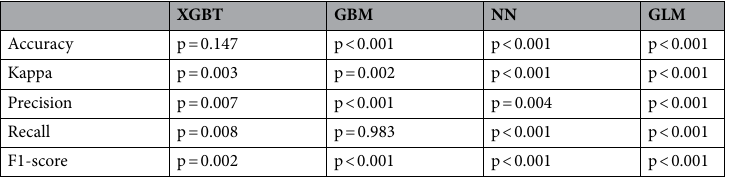
p < Table 9. T-test on metrics of random forest model and other models. XGBT extreme gradient boosting tree model, GBM gradient boosting model, NN neural network model, GLM generalized linear model. p is the t-test p-value.